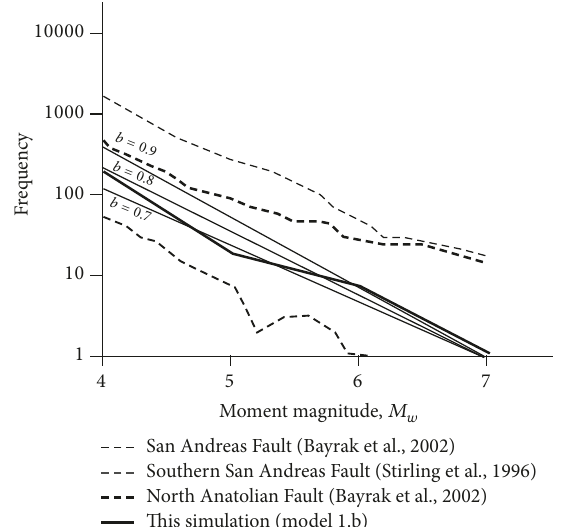
Figure 6: Frequency-magnitude plot of aftershocks on inac- tive segments following failure along the Joannes Segment in a model that includes the structural framework of southern Abitibi (model 1.b). Dotted lines show expected frequencies using the Gutenberg–Richter relationship for several 𝑏 values. Data for active modern settings are from Amelung and King [33] and Gibowicz and Lasocki [34] and are adjusted to 𝑀 𝑤 = 7